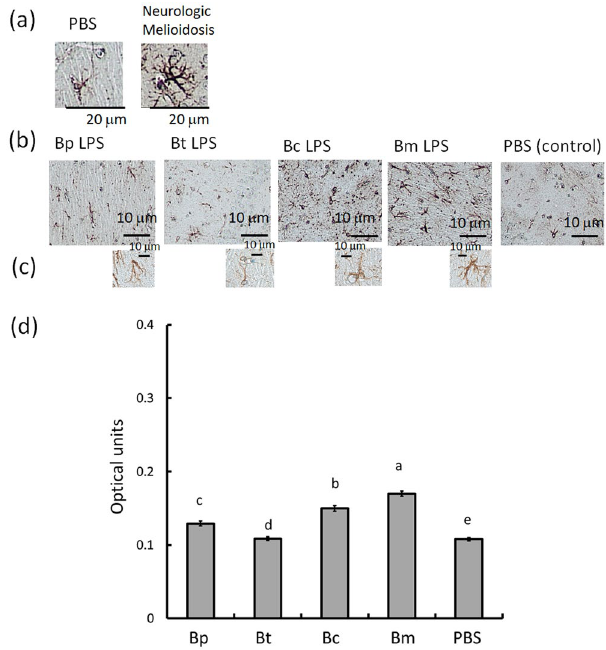
Figure 2. GFAP-expressing astrocytes. Histologic examination was used to identify GFAP-expressing astrocytes in the hippocampus ( a : left, PBS-treated controls; right, melioidosis brains; both 400X ). B. pseudomallei (Bp) LPS-, B. thailandensis (Bt) LPS-, B. cenocepacia (Bc) LPS- and B. multivorans (Bm) LPS- induced brains, and PBS-treated controls are shown ranked from left to right ( b ), all 100X ). A